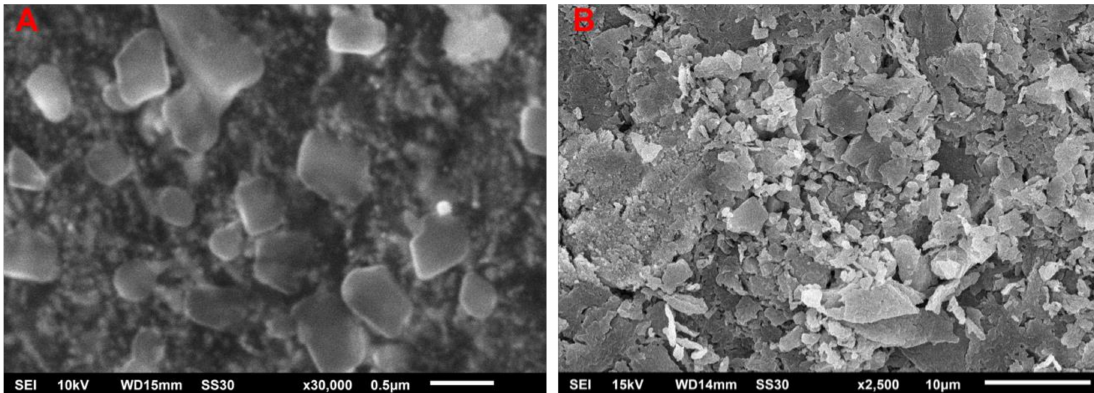
Figure 2. ( A , B ) SEM image of the biosynthesized AgNPs at different magnification showing rectangular